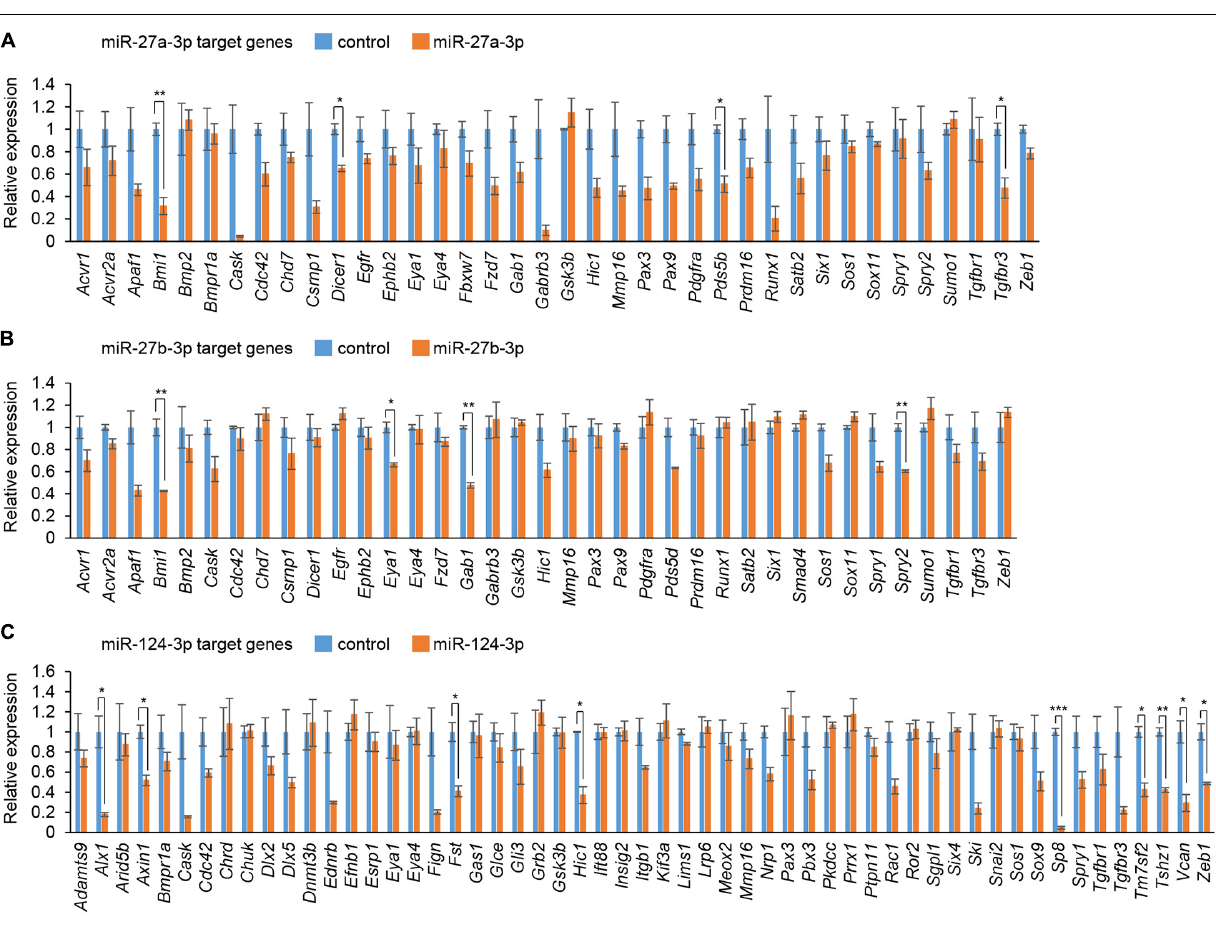
FIGURE 2 | Cleft palate-associated genes suppressed by overexpression of miR-27a-3p, miR-27b-3p, or miR-124-3p in MEPM cells. (A–C) Quantitative RT-PCR for the indicated genes after treatment with control or miR-27a-3p mimic (A) , control or miR-27b-3p mimic (B) , and control or miR-124a-3p mimic (C) . Multiple t -tests adjusted by Bonferroni ( n = 3). *Adjusted p < 0.00132 in A (38 genes), adjusted p < 0.00135 in B (37 genes), adjusted p < 0.000909 in C (55 genes), **adjusted p < 0.000263 in A (38 genes), adjusted p < 0.000270 in B (37 genes), adjusted p < 0.000182 in C (55 genes), ***adjusted p < 0.0000182 in C (55 genes).